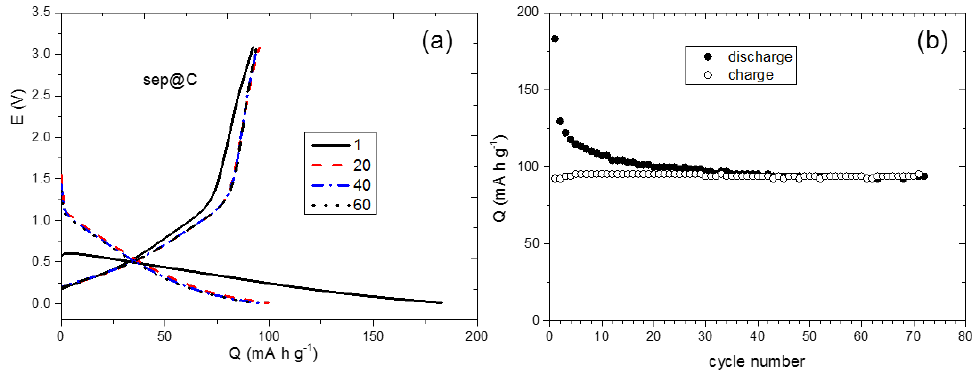
Figure 8. ( a ) Discharge-charge curves and ( b ) rate capability of Sep@C at various current densities.